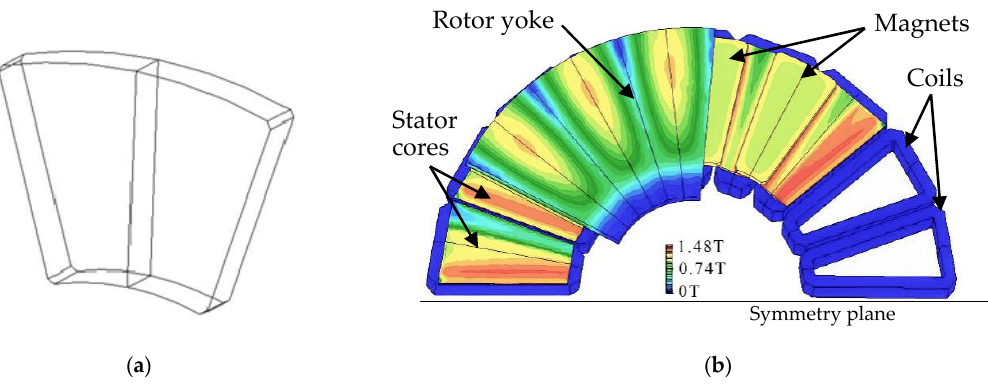
Table 1. Stator parameters.